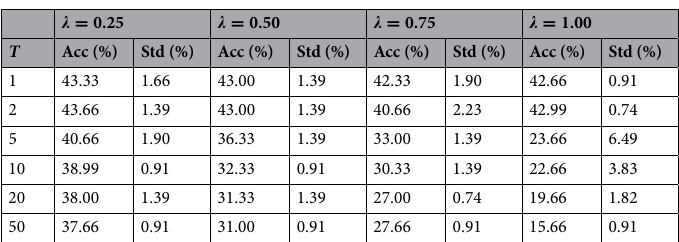
Table 6. Temporal shift models (TSM) 23 with subjects consensus.